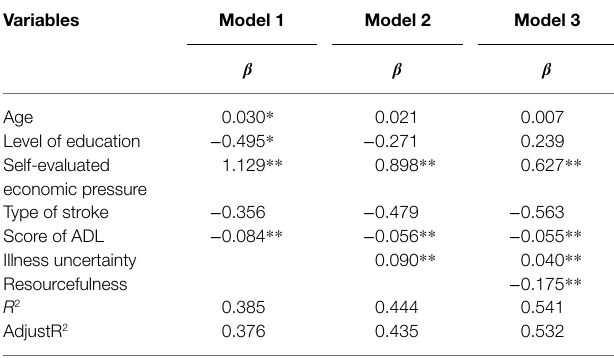
TABLE 4 | Hierarchical regression analysis on the PSD ( N =